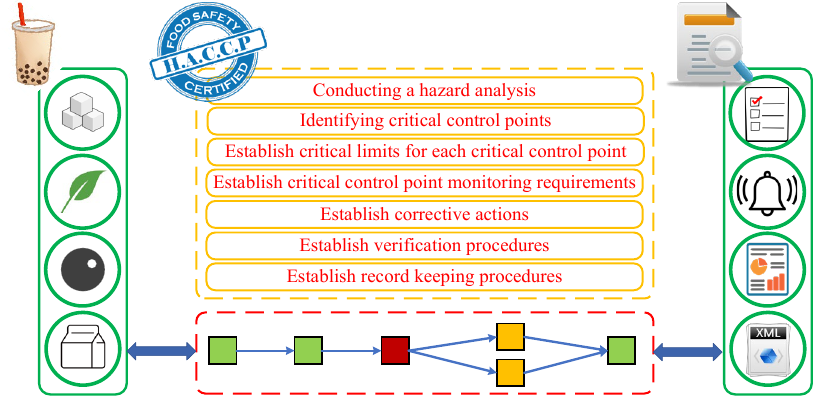
Figure 1. The scenario of IF4BT.